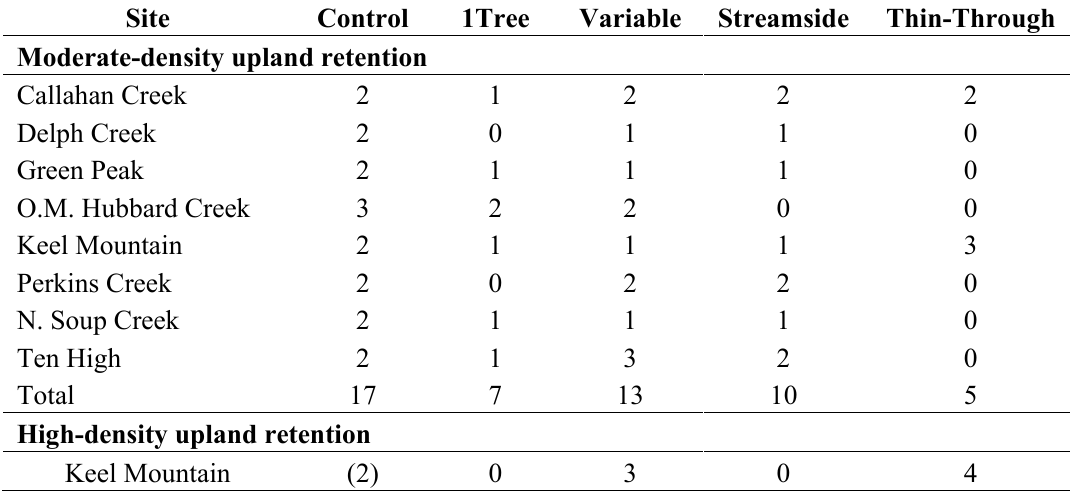
Table 1. The number of replicate stream reaches with alternative riparian buffer treatments (1Tree (one site-potential tree-height buffer), variable, streamside, thin-through) and untreated controls at eight study sites with upland forests thinned twice to moderate residual tree densities and one site thinned twice to high residual tree densities, in western Oregon, USA; parentheses indicate that these control reaches are represented above in the controls for the moderate-density